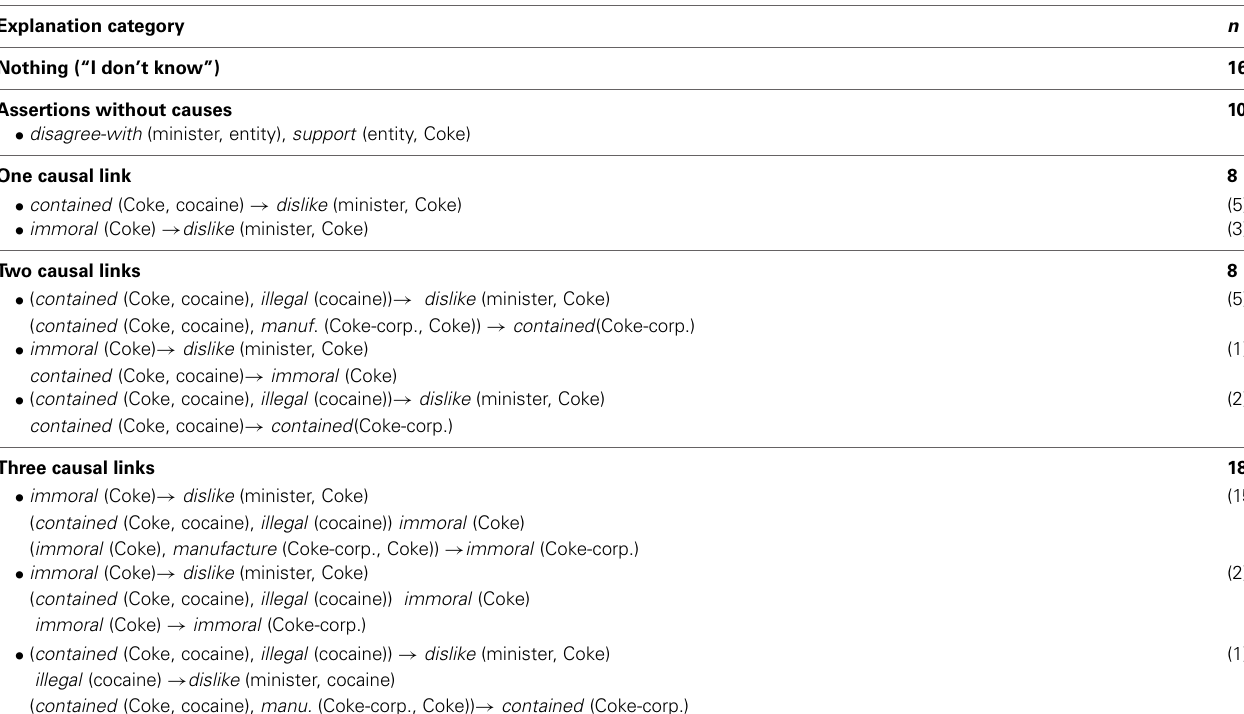
Table 2 | Summary of the number ( n ) of each category of explanation the model generated in Simulation 2. Explanation